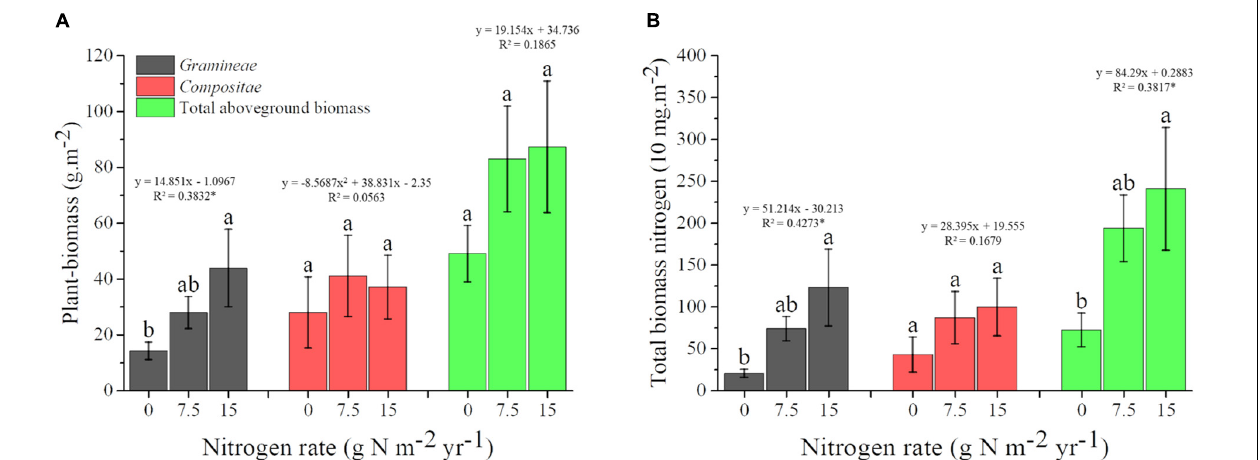
FIGURE 3 | Changes of plant-biomass (A) and total biomass nitrogen (B) under different N application rate. Treatments are expressed by data with means ± SE ( n = 4). Different letters above boxes indicate significant differences between N application rates at the P < 0.05. Results of regression analysis were shown above boxes using its function and R2. The * indicates there were significant correlations between plant traits and N application rates at the P < 0.05